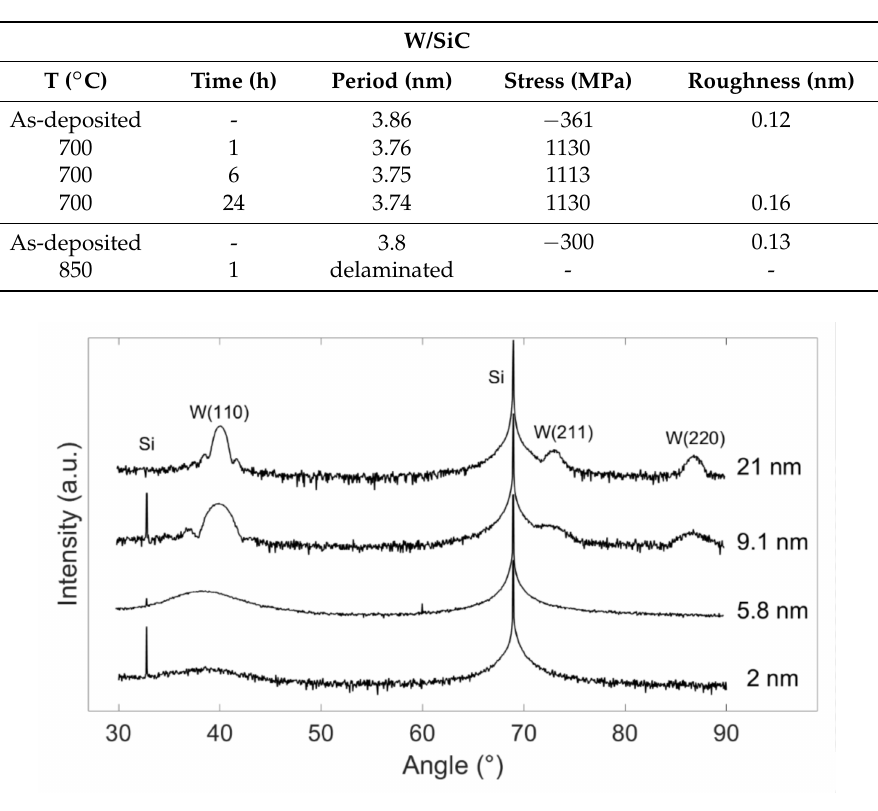
Figure 9. HAXRD scans of as-deposited W/SiC multilayers of different multilayer period thicknesses.